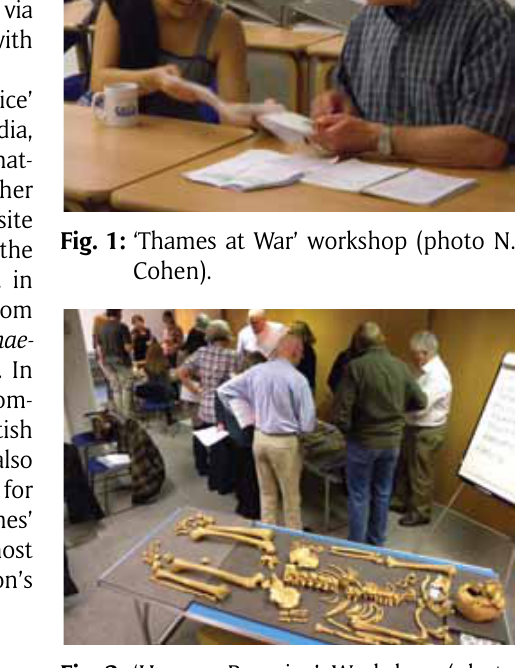
Fig. 2: ‘Human Remains’ Workshop (photo N.